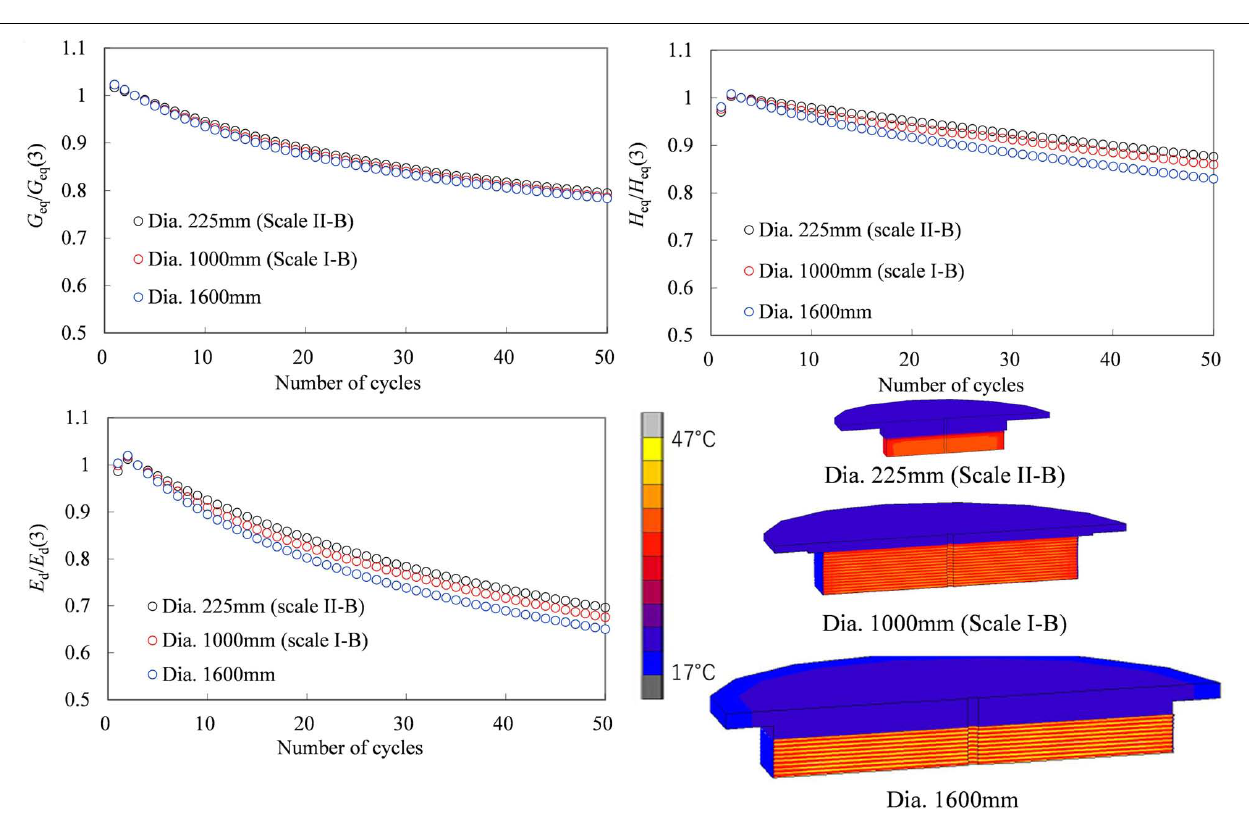
Frontiers in Built Environment |